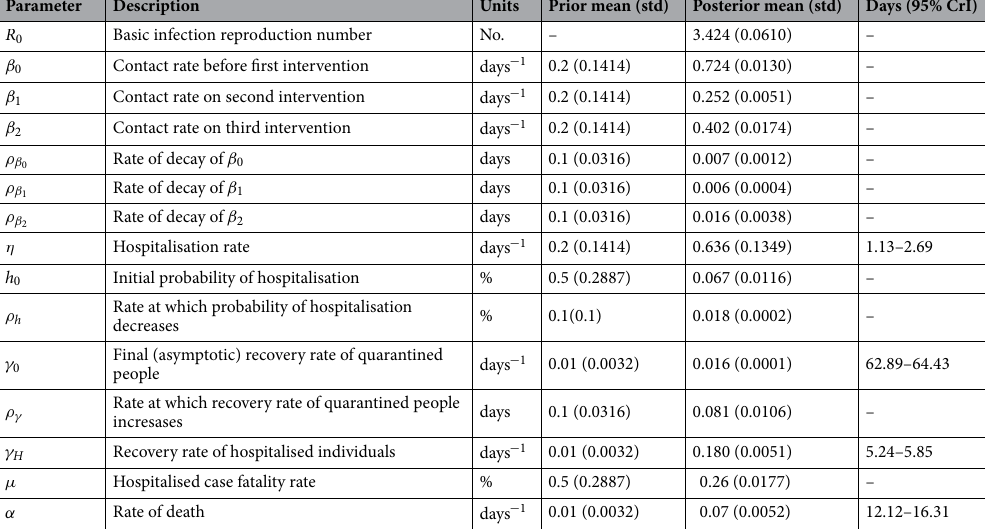
Table 2. Posterior statistics of SEIQRHD model parameters.